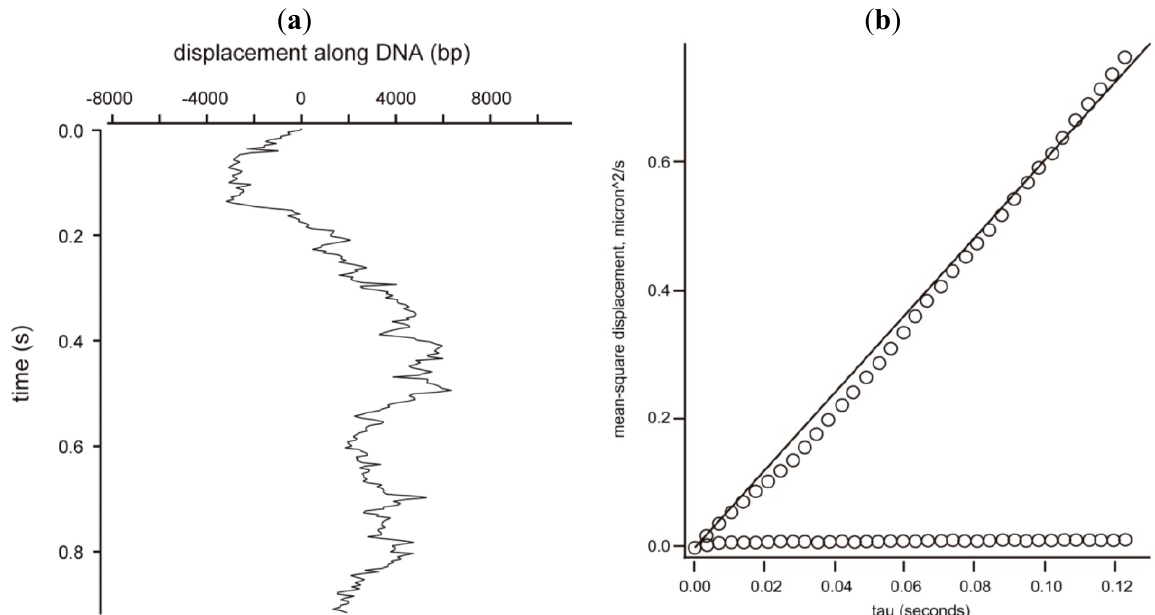
Figure 5. Sliding of the AVP-pVIc complex along DNA. ( a ) An AVP-pVIc complex sliding almost 16,000 bp in less than 1 s; ( b ) Mean square displacement (MSD) versus time of the data in ( a ). The MSD is the square of the distance traveled. The slope of the curve is the one-dimensional diffusion constant for this slide, 32 × 10 6 bp 2 /s. The line parallel to the abscissa is the MSD from the Y -axis versus